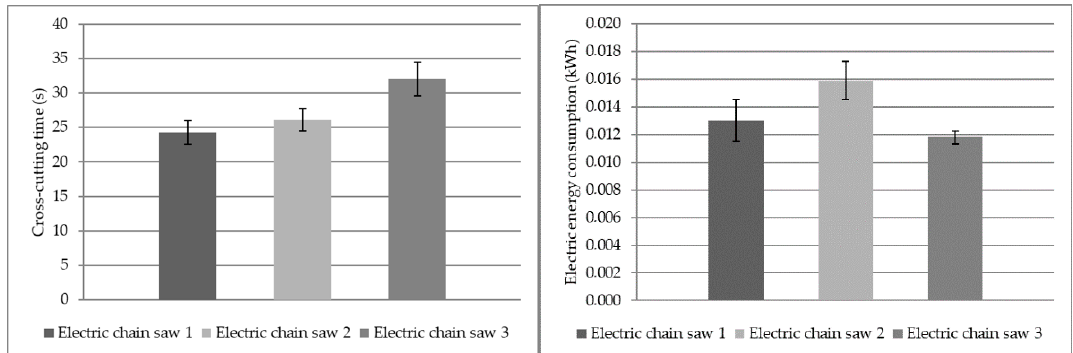
Figure 2. ( a ) Cross-cutting time and electric energy consumption by the type of electric chainsaw— mean and 95 % confidence interval ( b ) Electric energy consumption by type of electric chainsaw— mean and 95 % confidence interval.